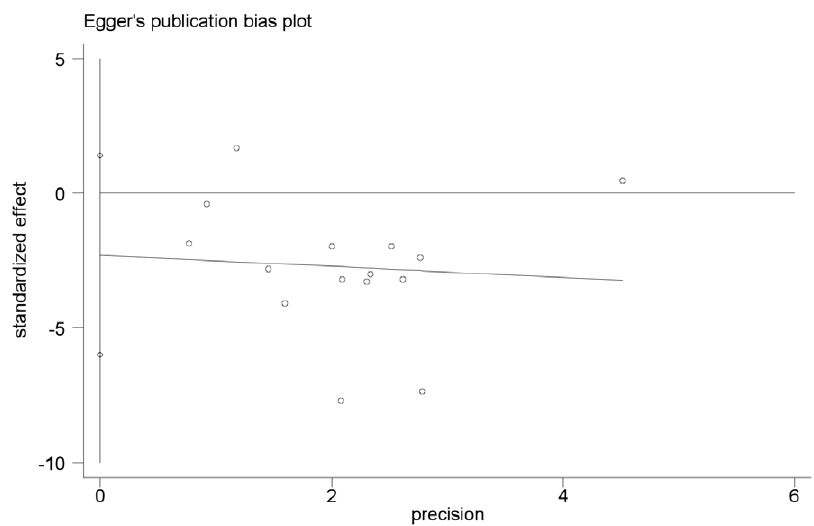
Figure 5. Egger’s test result of 5-year OS rate.